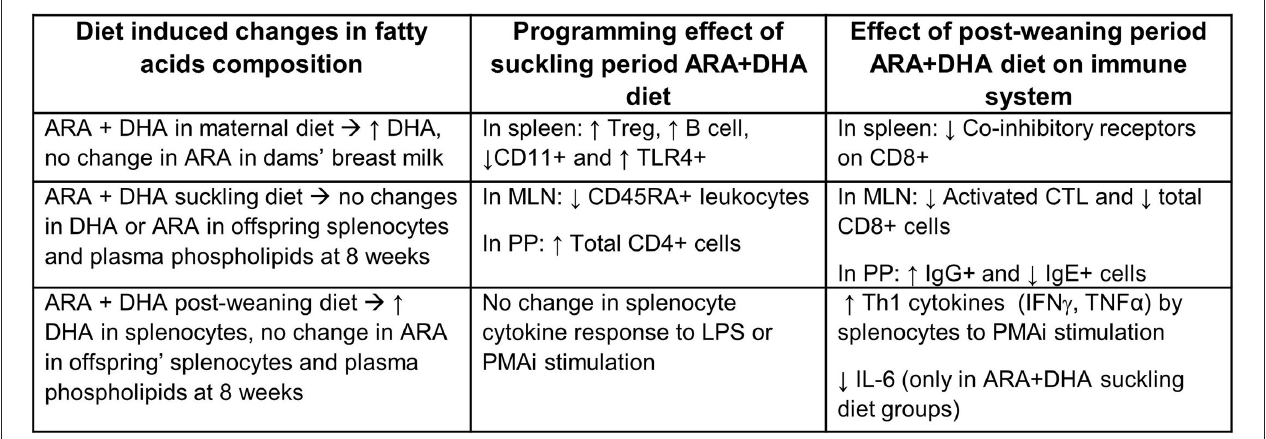
FIGURE 5 | Summary of significant effects of supplementing ARA + DHA in infant diets on the immune system development of Brown Norway offspring. ↑ , increase; ↓ , decrease; ARA, arachidonic acid; DHA, docosahexaenoic acid; Treg, T regulatory cell, CTL, cytotoxic T cells; TLR4, toll-like-receptor 4; LPS, lipopolysaccharide; MLN, mesenteric lymph node; PP, Peyer’s